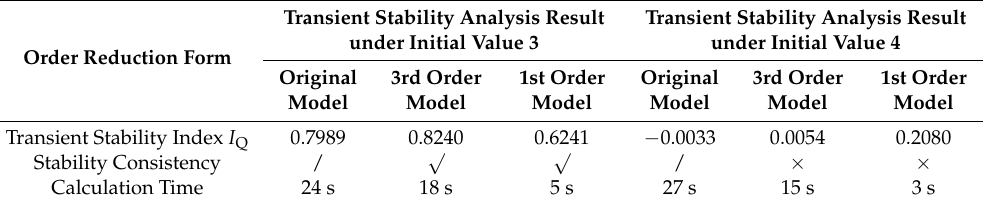
Table 4. Transient stability analysis result of test system 1.